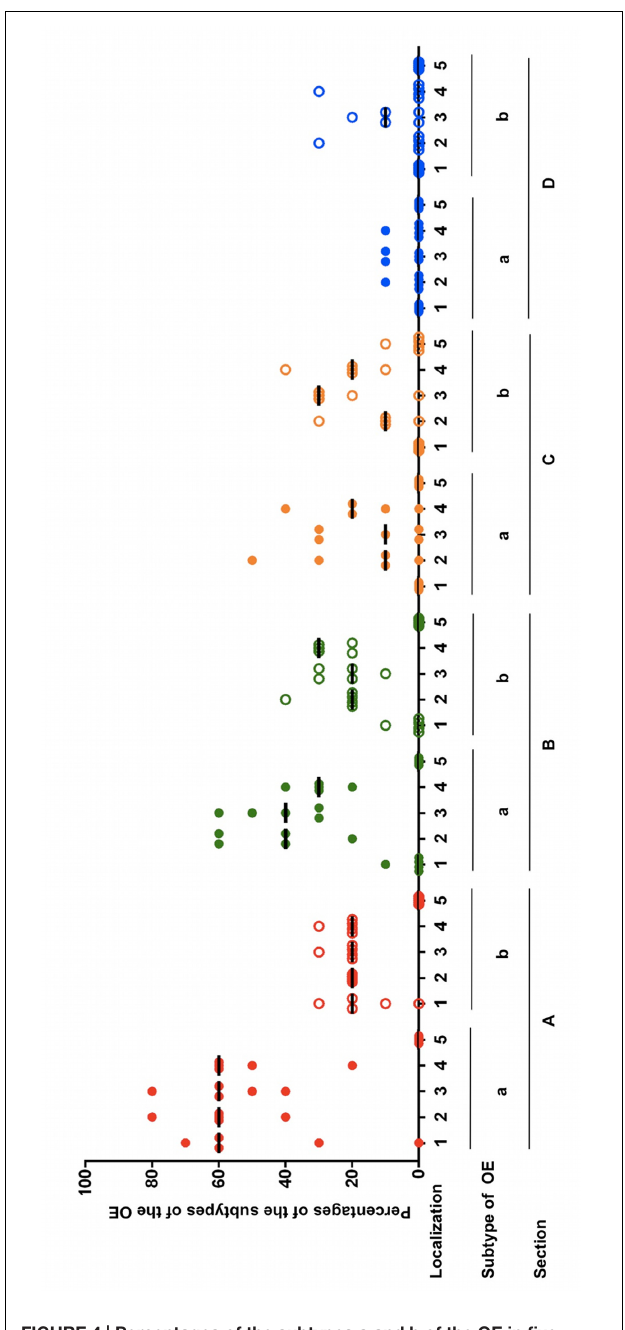
FIGURE 4 | Percentages of the subtypes a and b of the OE in five equine noses for all sections containing OE (A–D), split up for localizations 1–5; (1) nasal septum, (2) dorsal, (3) mid, (4) ventral part of the nasal turbinates, (5) lining of the nasal cavity; bar: